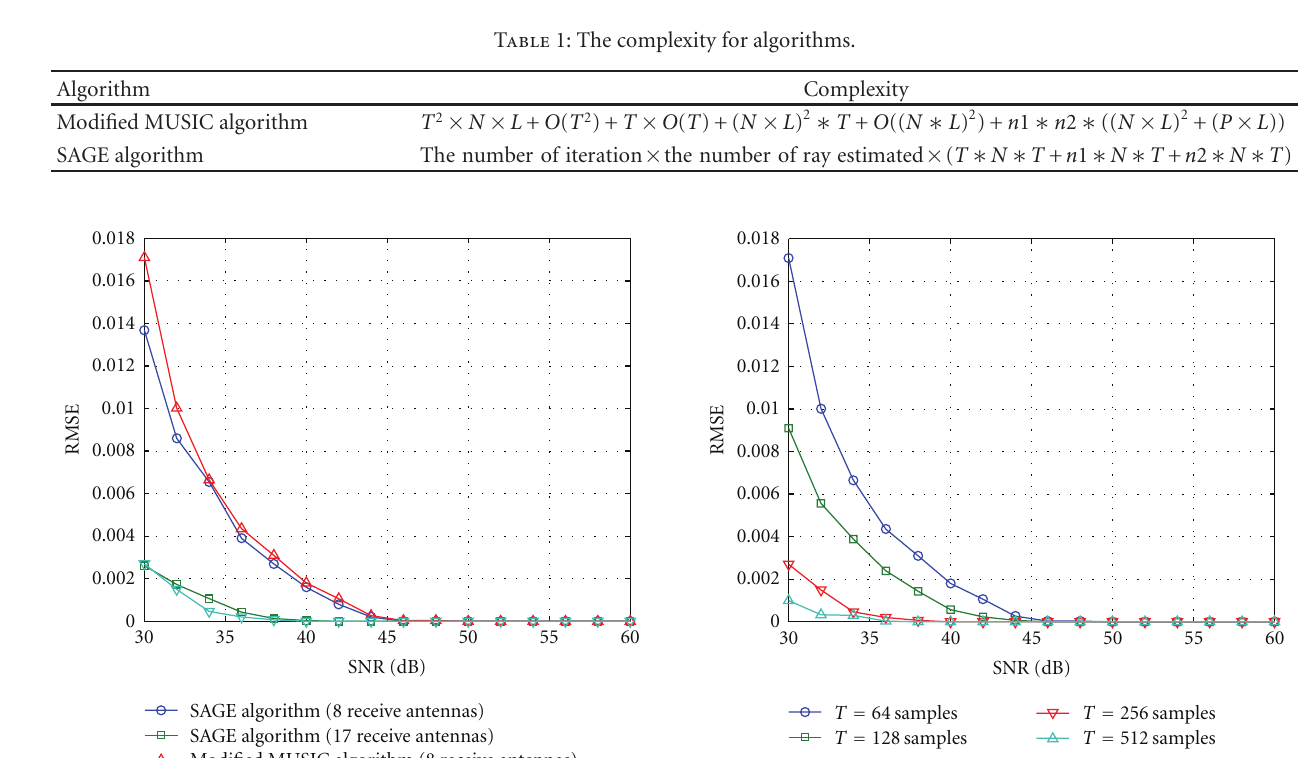
Figure 6: The DOA estimationperformance with di ff erent